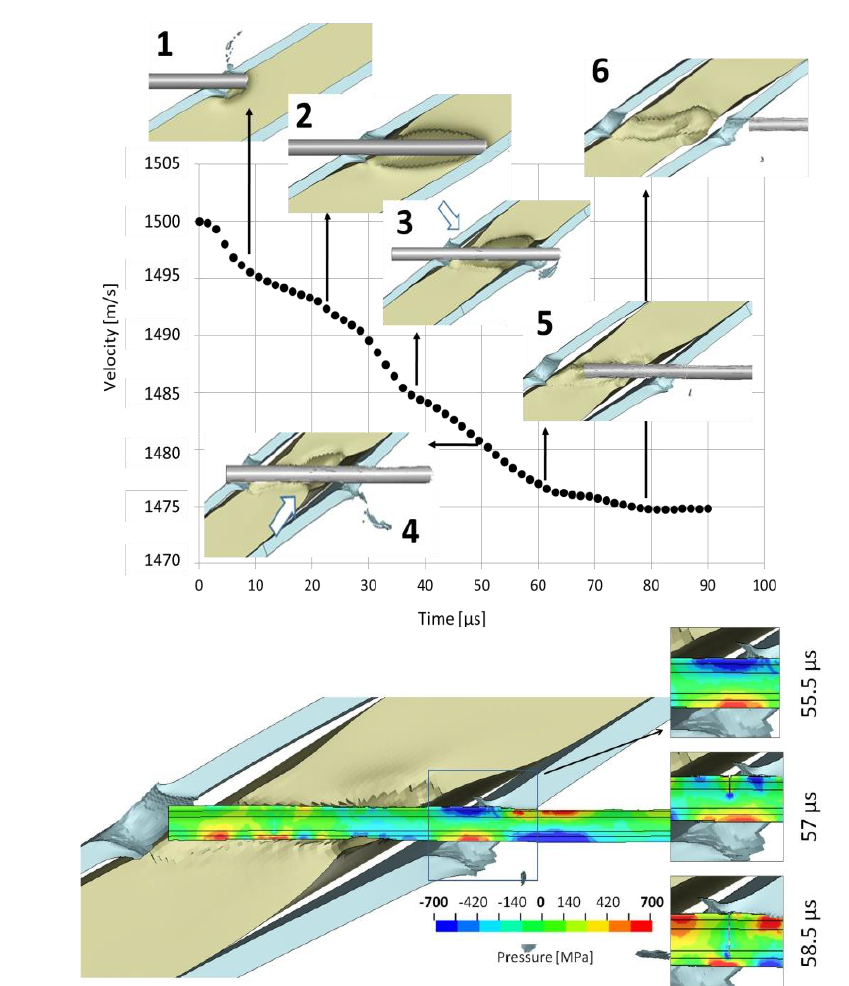
Figure 8. Long-rod projectile and ( a ) drop of its impact velocity, ( b ) fracture initiation (the hydro- static pressure positive in